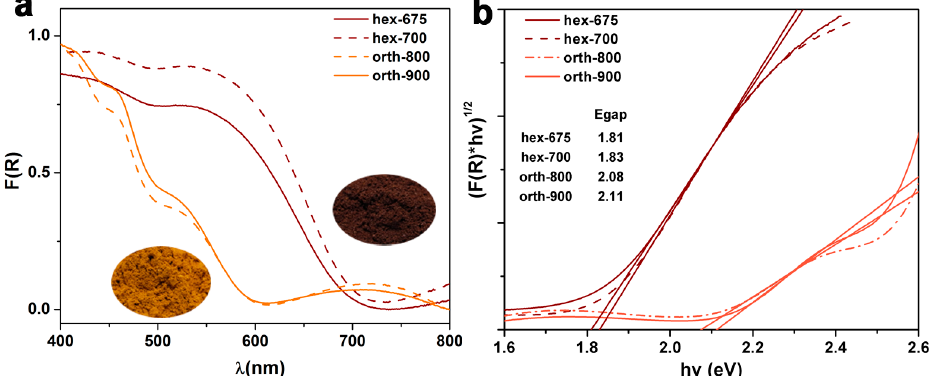
Figure 3. ( a )Kubelka-Munkfunction(F(R))vs. wavelength, showingtheabsorptiononsets. Theinsetsshow the colors of the YFeO 3 powders ( b ) Tauc plots for indirect band gap determination of the YFeO 3